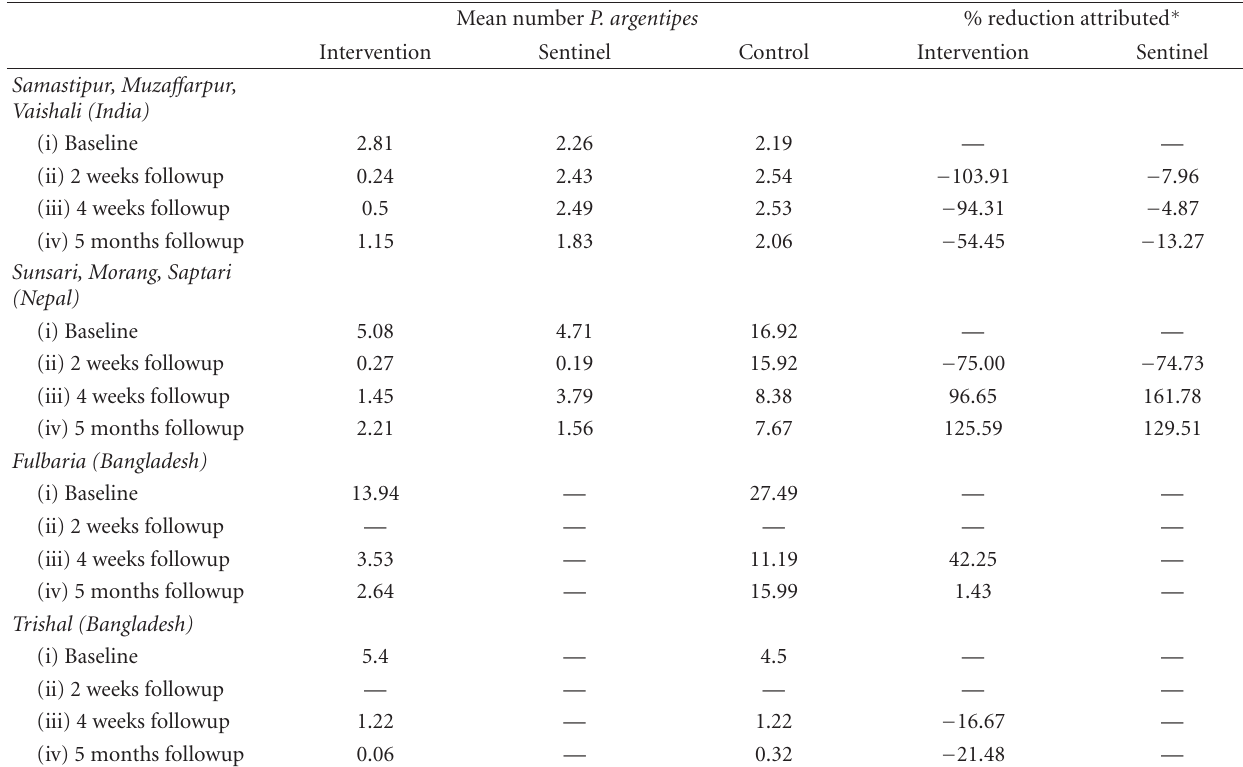
Table 5: Findings of outcome indicator: Sandfly